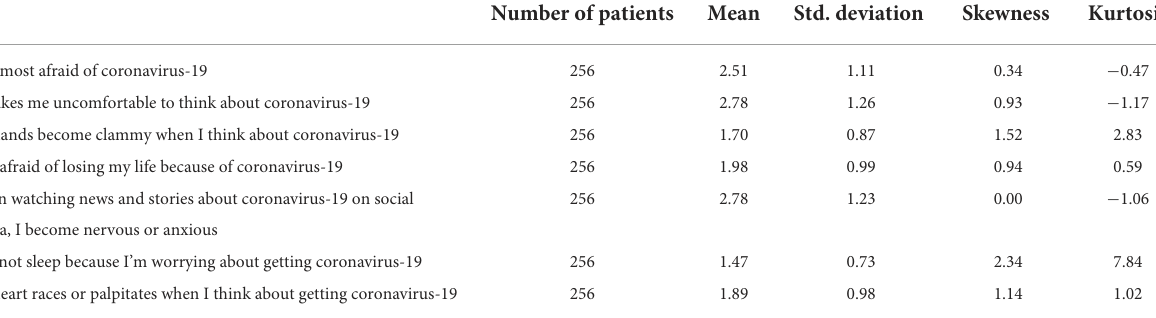
TABLE 3 Fear of COVID-19 scale; mean values, standard deviation, skewness and kurtosis of responses to